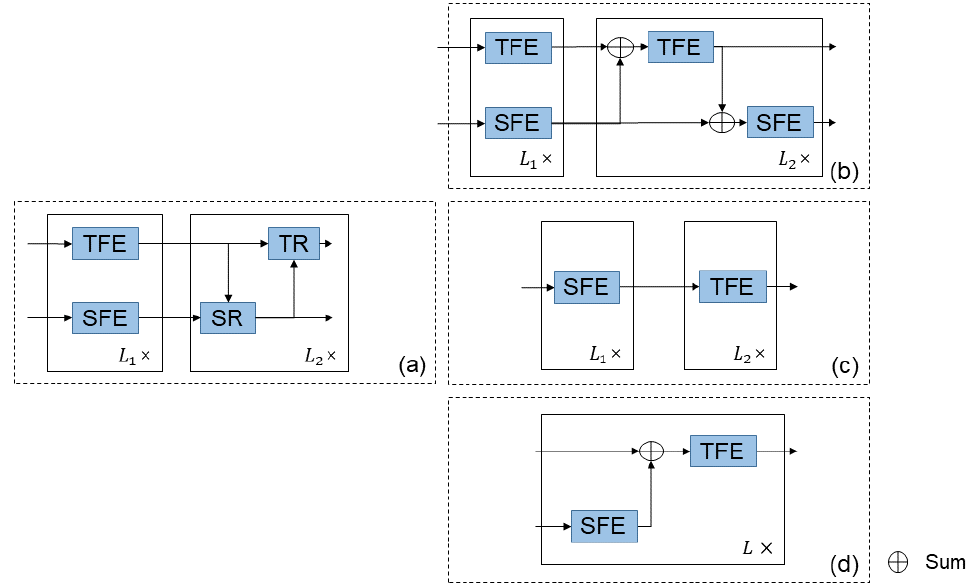
Figure 5. Structure analysis. ( a ) The abstracted model proposed in this paper. ( b ) A special case of replacing the MCA with a summation method in the CDI. ( c ) The structure of PoseFormer. ( d ) The structure of TNT. L , L 1 , and L 2 are the number of layers of the corresponding